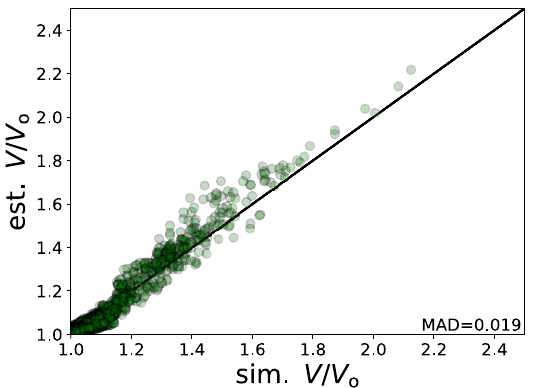
Fig. 4 Parity plot illustrating the predictive capability of Eqs. (3) – (6). The estimated (est.) swelling from correlations based on readily obtainable adsorbate and adsorbent properties is compared to the simulated (sim.) swelling.